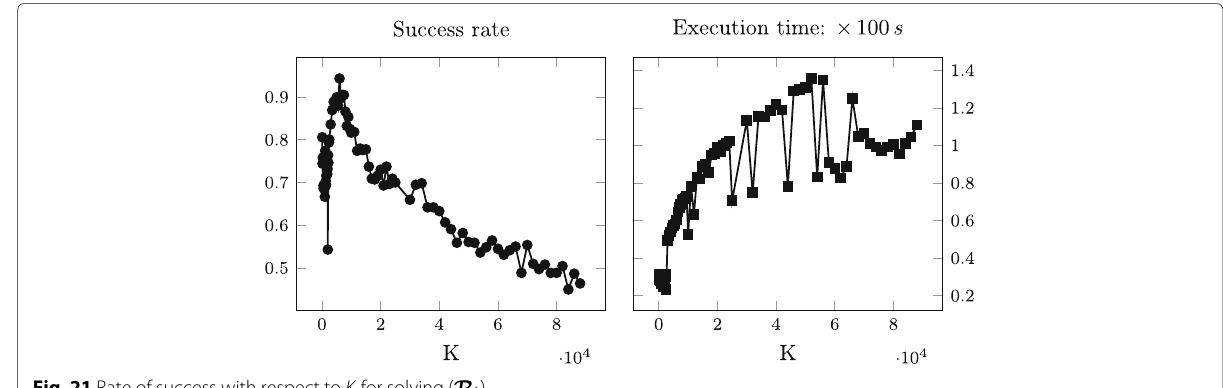
Fig. 21 Rate of success with respect to K for solving ( P A )